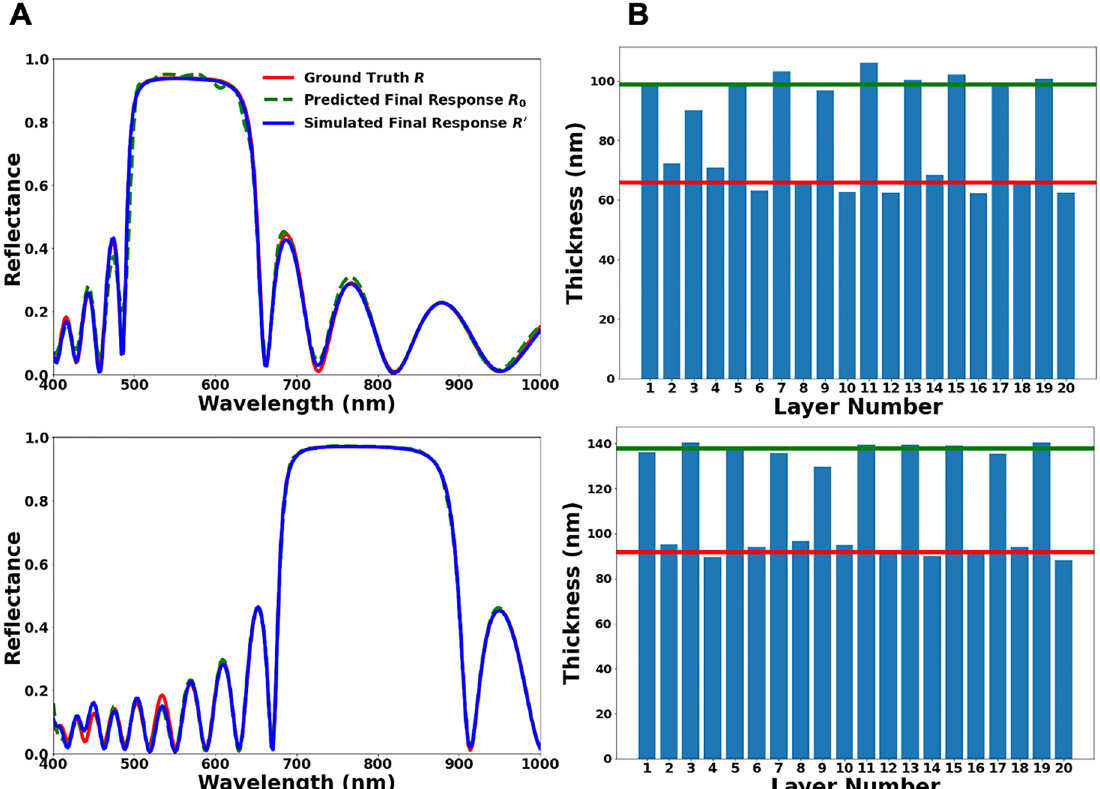
Figure 3: Inverse design of DBRs consisting of alternating high- and low-index films of quarter-wavelength thicknesses stacked in a periodic